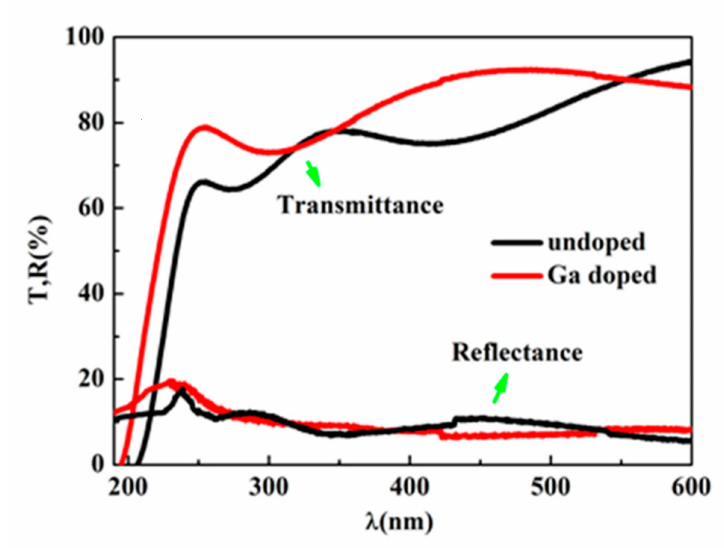
Figure 4. Optical properties of ZnMgO samples with and without Ga dope. The relation between the transmittance ( T ) and absorption coefficients ( a ) can be expressed as [42]: